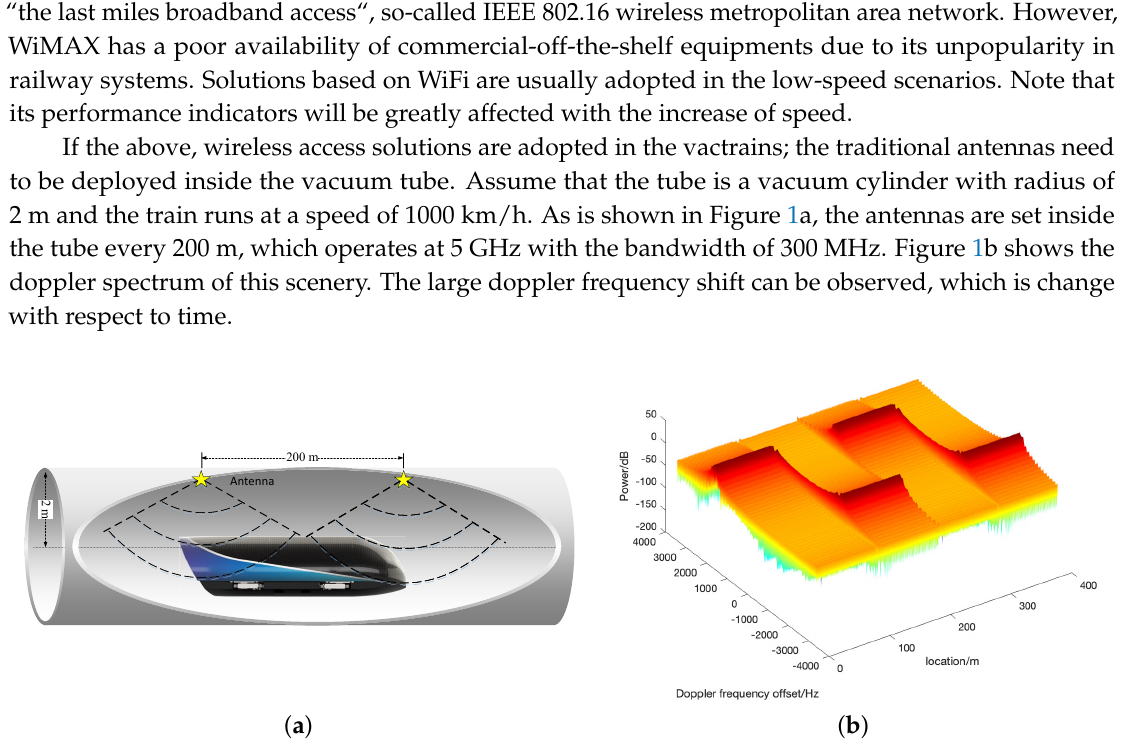
Figure 1. Simulation of the antennas methods: ( a ) Configuration of antennas methods. ( b ) Doppler spectrum of antenna